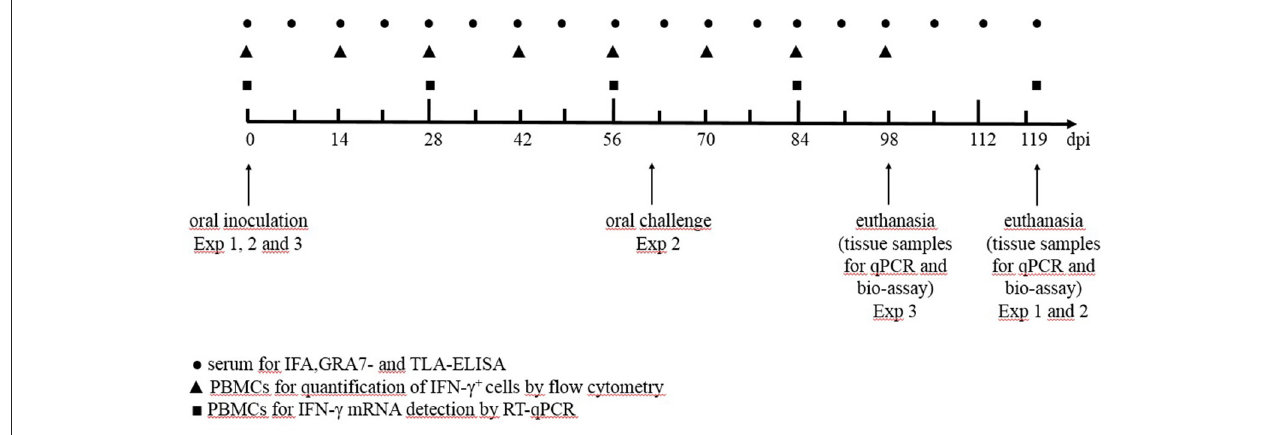
FIGURE 1 | The timeline of the experiments from the inoculation (day 0 dpi) until euthanasia (day 120 dpi). Exp, experiment; • serum for IFA, GRA- and TLA-ELISA; N PBMCs for the quantification of IFN- γ + T-lymphocytes by flow cytometry; (cid:4) PBMCs for IFN- γ mRNA detection by